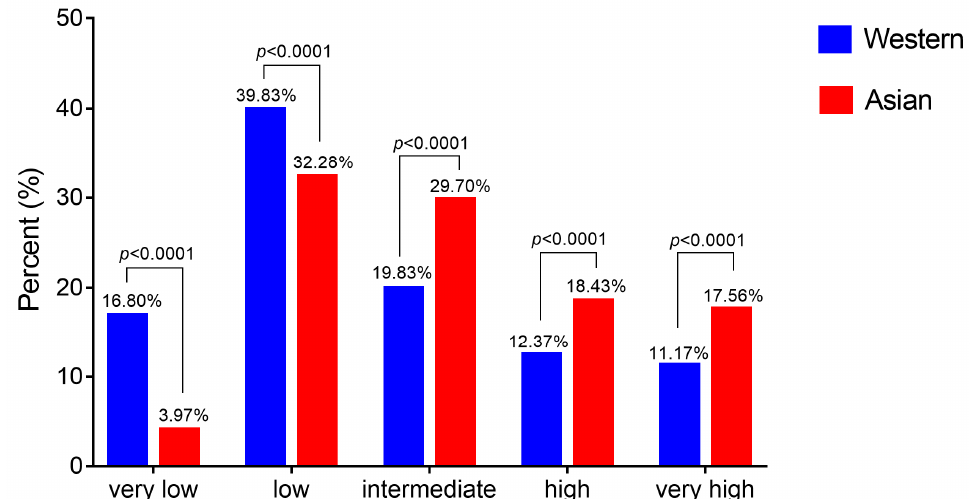
Figure 5. Distribution depending on IPSS-R in Western and Asian countries. The graph was drawn upon publications [26,29,31,36,39,41–47]. Raw data and statistical analysis are presented in Supple- mental Table